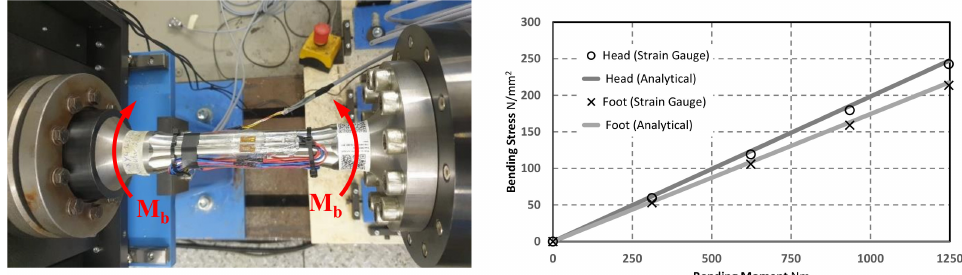
Figure 13. Testbench for the bending load, with a strain-gauge application ( left ); comparison of the analytical solution of Equation (55) with the experimental data ( right ) [2].